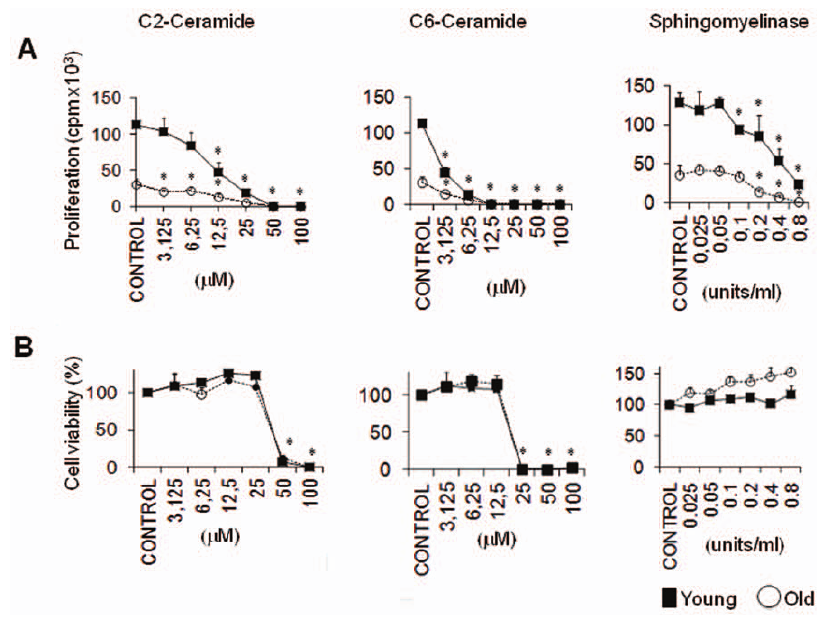
Figure 6. Both synthetic Cer and enzymatic Cer production inhibit CD4 + T cell proliferation. Young or old murine CD4 + T cells were pre- incubated with graded concentrations of the indicated compounds. After two hours, cells were activated in triplicate wells containing plate-bound anti-CD3 and soluble anti-CD28 antibodies, and incubated for another 72 hours in the presence of these compounds. ( A ). 3 H-thymidine was added for the last 6 hours to monitor CD4 + T cell proliferation. Each data point represents mean counts per minute (CPM) 6 SD of triplicate wells, each well containing 1 6 10 5 purified young or old CD4 + T cells pooled from 3–5 mice. Asterisks indicate p , 0.05 versus the corresponding untreated controls. The difference between the proliferation of control young and old CD4 + T cells is highly significant ( p , 0.001). One representative experiment of three is shown. ( B ). Cells treated as in (A) were tested for cell viability by staining with annexin V and propidium iodide (PI), prior to the addition of 3 H- thymidine. Graphs illustrate the percent viable cells (PI negative, annexin V negative), after normalization to the untreated control samples, which were set to 100%. All statistics are as in (A).